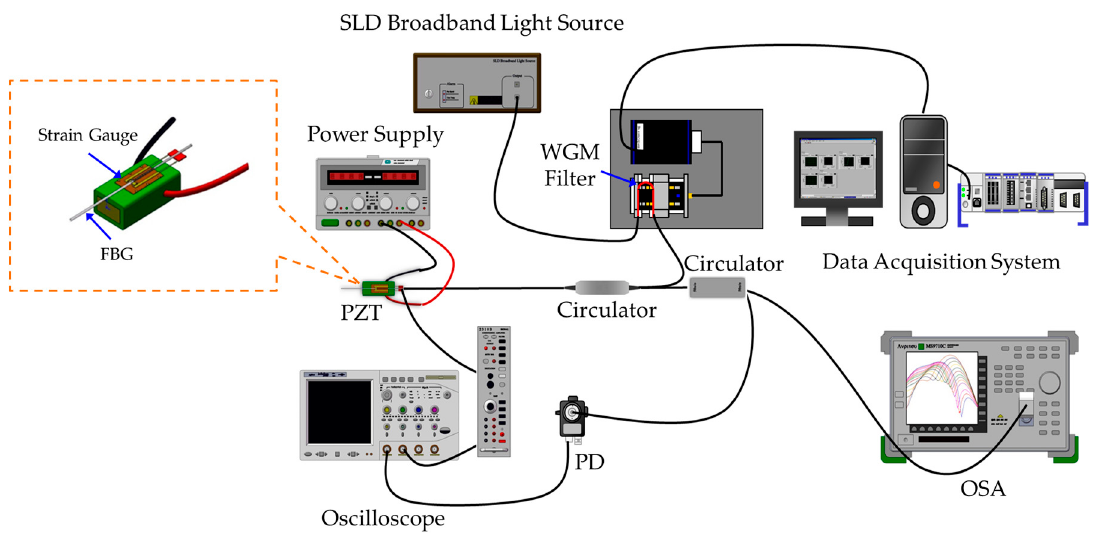
Figure 6. Schematic diagram of the experimental structure of the FBG intensity modulation system based on a WGM edge filter. PD: photo detector.